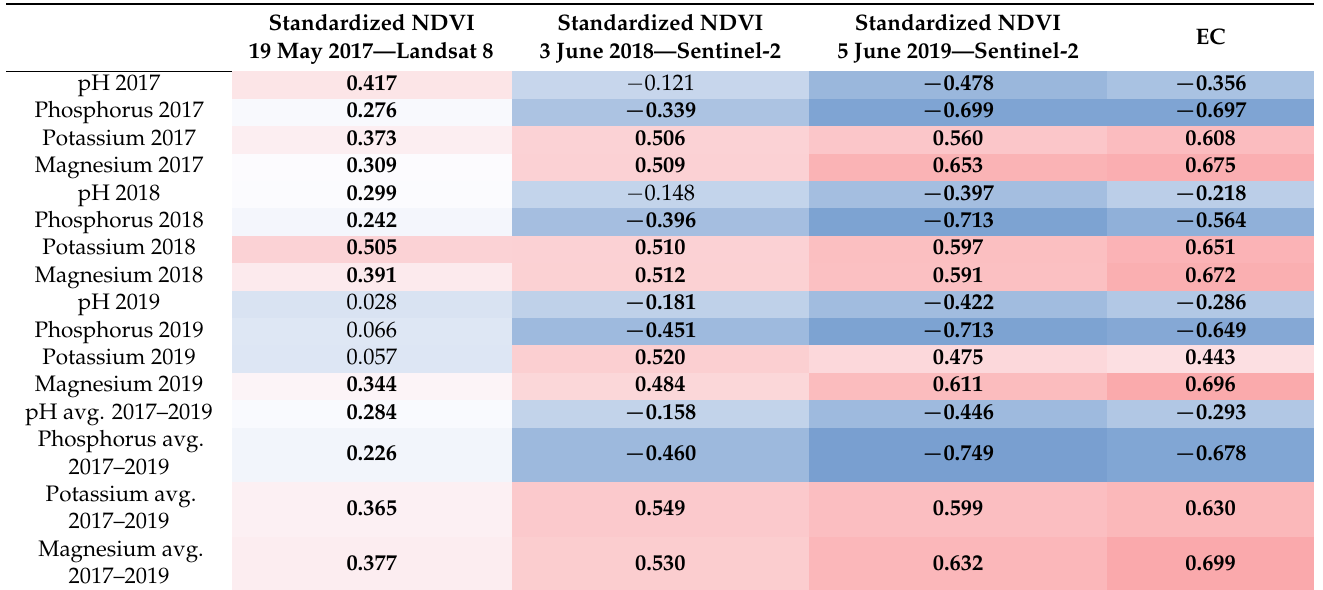
Table 6. Correlation coefficients between EC and standardized NDVI with soil pH and nutrients con- tent for winter wheat (significant correlations at 0.05 significance level are in bold; color background scale for correlations the same as in Table